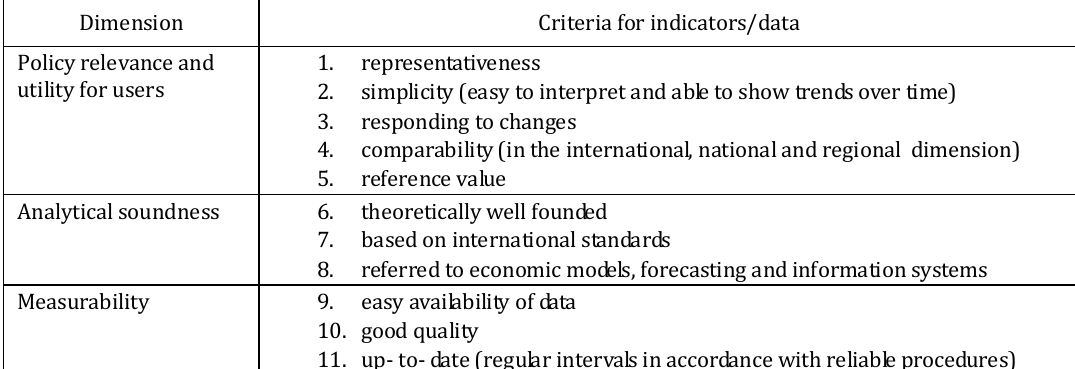
Table 1. Criteria for Indicator Selection (PSR model) (Source: own elaboration based on OECD, 1993)